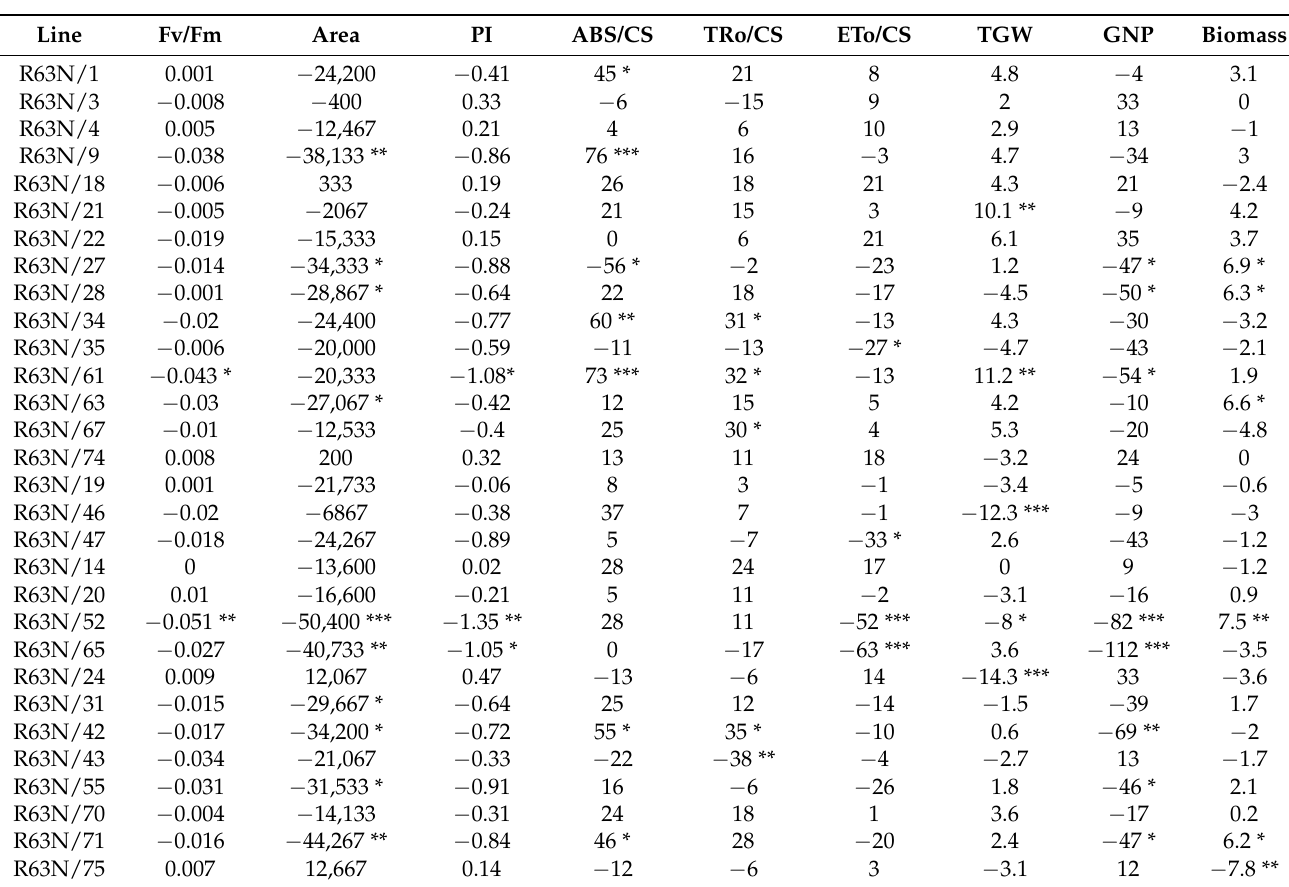
Table 3. Heterosis coefficients for individual quantitative traits barley DH